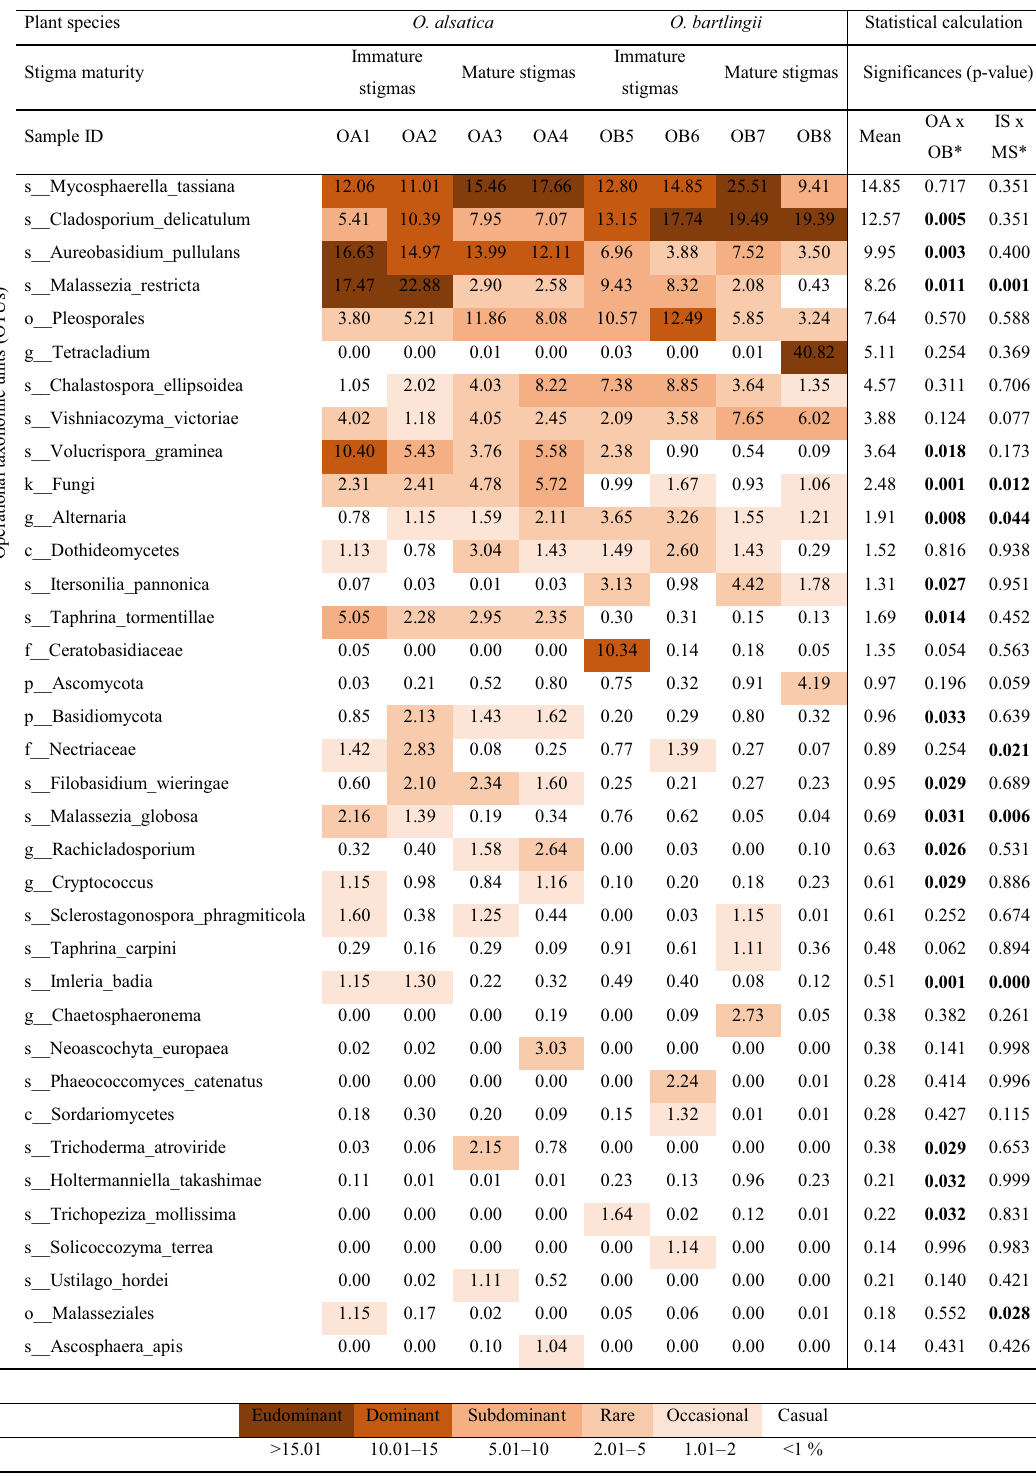
Table 3. Frequency (%) of fungi identified in Orobanche alsatica (OA) and O. bartlingii (OB) in immature stigmas from closed flowers (1, 2, 5, 6) (IS) and mature stigmas from opened flowers (3, 4, 7, 8) (MS) and statistical calculation. *Only OTUs with significant biological differences ( P < 0.05) were marked. Significant values are in